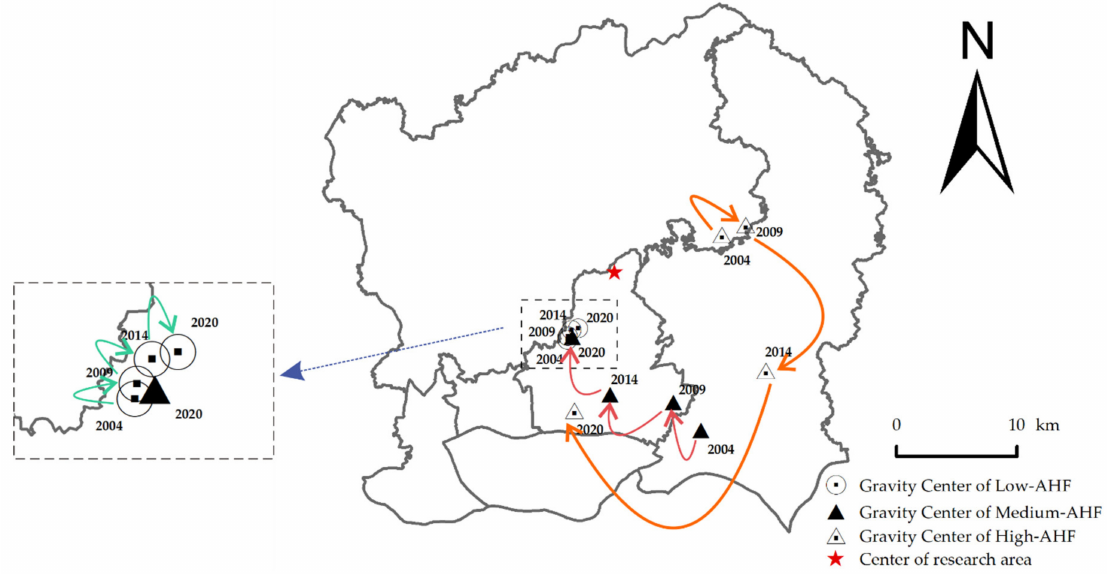
Figure 6. Migration of gravity center of different anthropogenic heat level